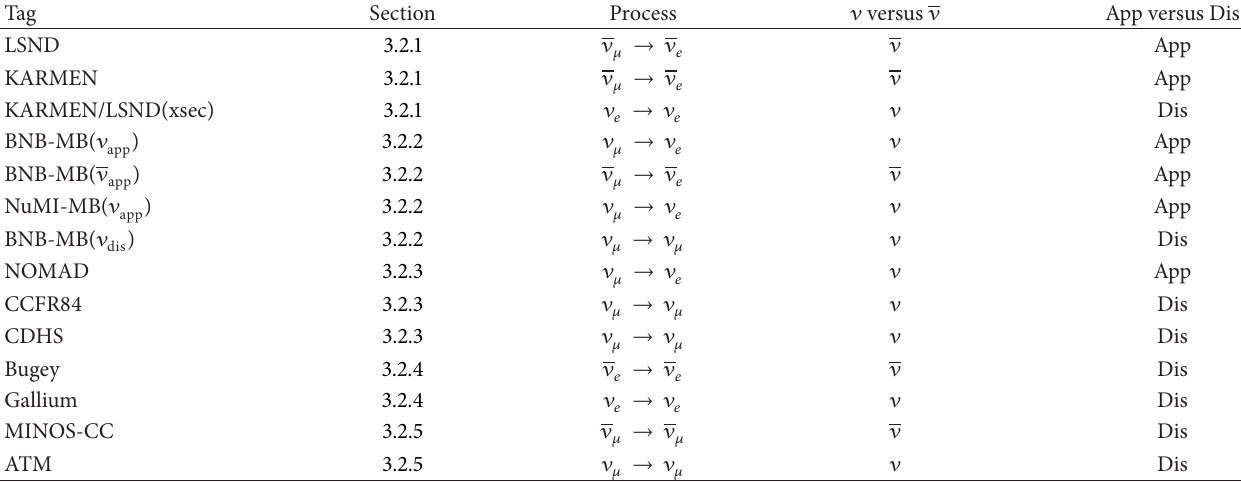
Table 1: Datasets used in the fits and their corresponding use in the analysis. Column 1 provides the tag for the data. Column 2 references the description in Section 3.2. Column 3 lists the relevant oscillation process. Column 4 lists which datasets are included in the neutrino versus antineutrino analyses and column 5 lists which datasets are included in the appearance versus disappearance study.